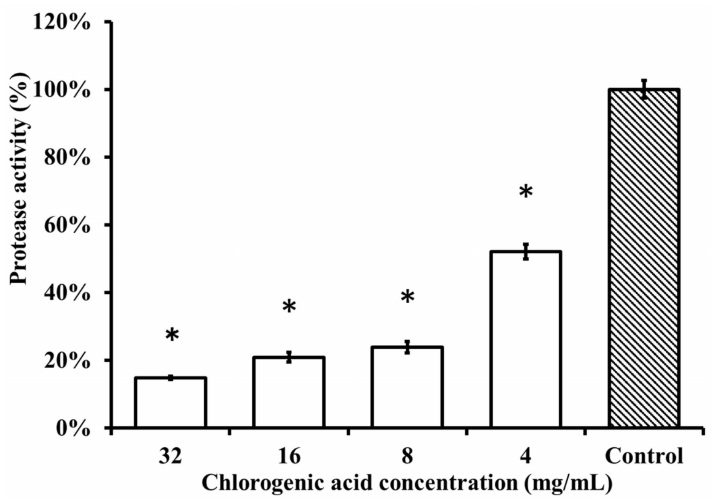
Figure 4. Chlorogenic acid inhibited the protease activity of Porphyromonas gingivalis (ATCC 33277) by the bacterial protease activity test. Percentage value changes in the protease activity of the P. gingivalis strain after treatment with chlorogenic acid at concentrations of 32, 16, 8, and 4 mg / mL, respectively, and treated with 10% dimethyl sulfoxide (DMSO) as the negative control group. The test indicated a significant di ff erence between each concentration of the chlorogenic acid groups and 10% DMSO of the negative control group (* p < 0.001).